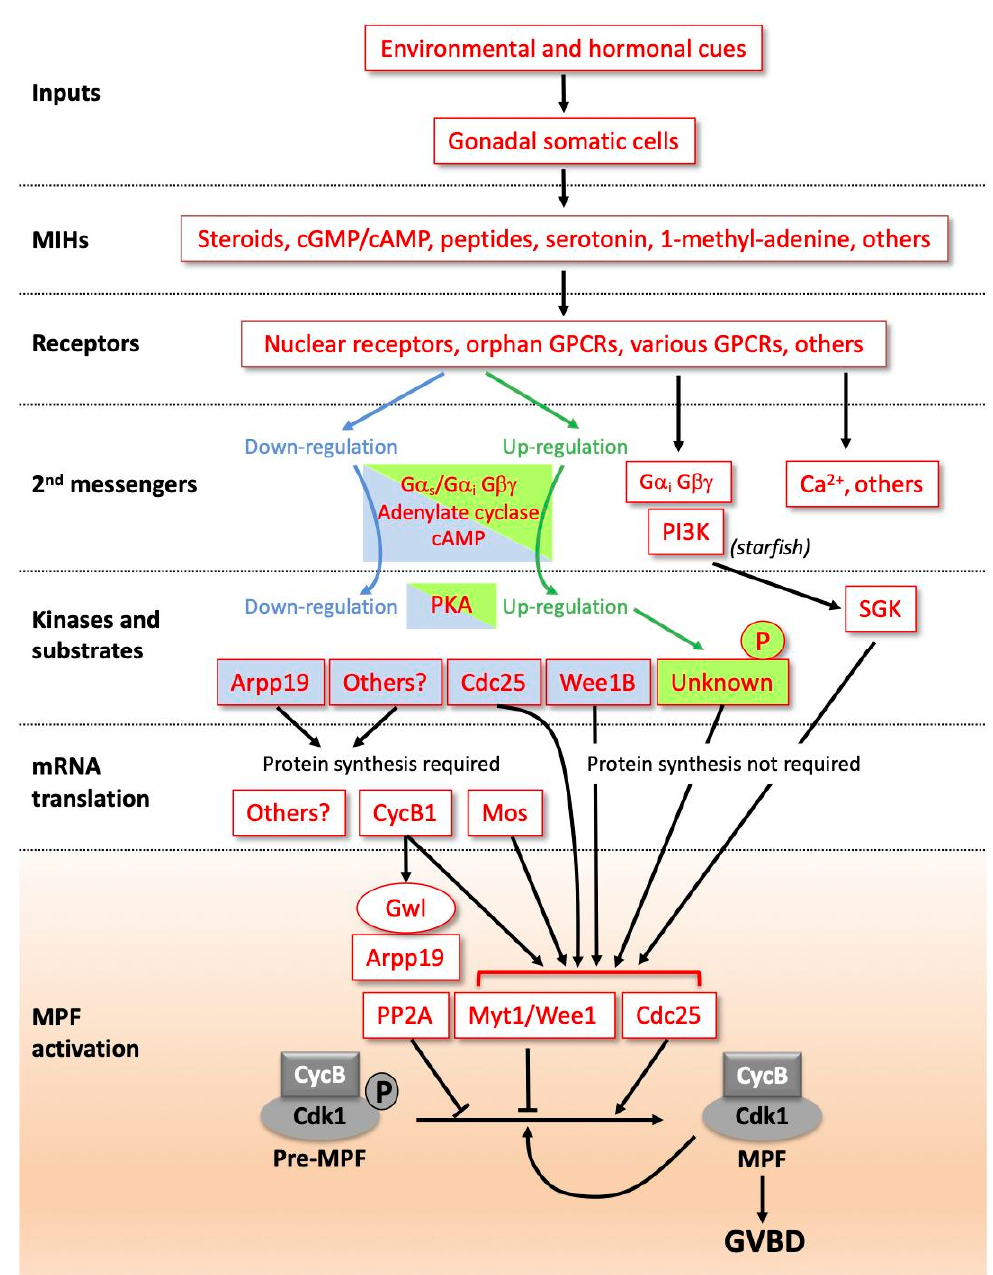
Figure 1. Diverse signalling pathways initiated by maturation initiation hormones (MIHs) lead to a universal biochemical core, activating maturation promoting factor (MPF). Due to the diversity of molecular pathways controlling the resumption of meiosis, this scheme is not exhaustive but is based on a few examples among those studied. MIHs are released from somatic cells near the oocyte (follicle cells, ectoderm cells or others) in response to hormonal (luteinizing hormone (LH) in vertebrates or gonad-stimulating substance (GSS) in starfish) and environmental inputs (dark/light transition, temperature, sea water, etc). MIH molecules have different identities between species, and the types of receptors mediating the MIH action are also diverse; see text for details. In amphibian and fish oocytes, steroids recruit canonical nuclear receptors unusually associated with membranes in oocytes, but also progestin-specific membrane receptors most probably acting through G α i and G βγ . MIH